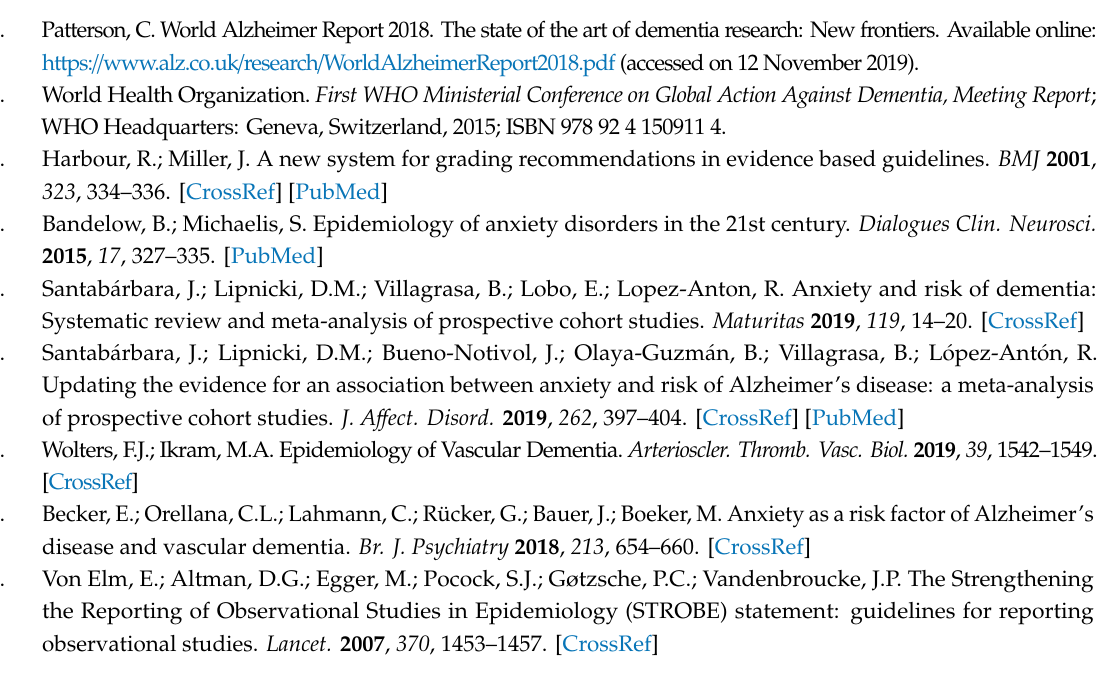
Figure S1: Flowchart of literature search and study selection, Figure S2: Sensitivity analysis, Table S1: PRISMA checklist, Table S2: Search strategy, Table S3: Quality assessment of cohort studies in the meta-analysis using the Newcastle–Ottawa scale (NOS), Table S4: Quality assessment of case-control studies in the meta-analysis using the Newcastle–Ottawa scale